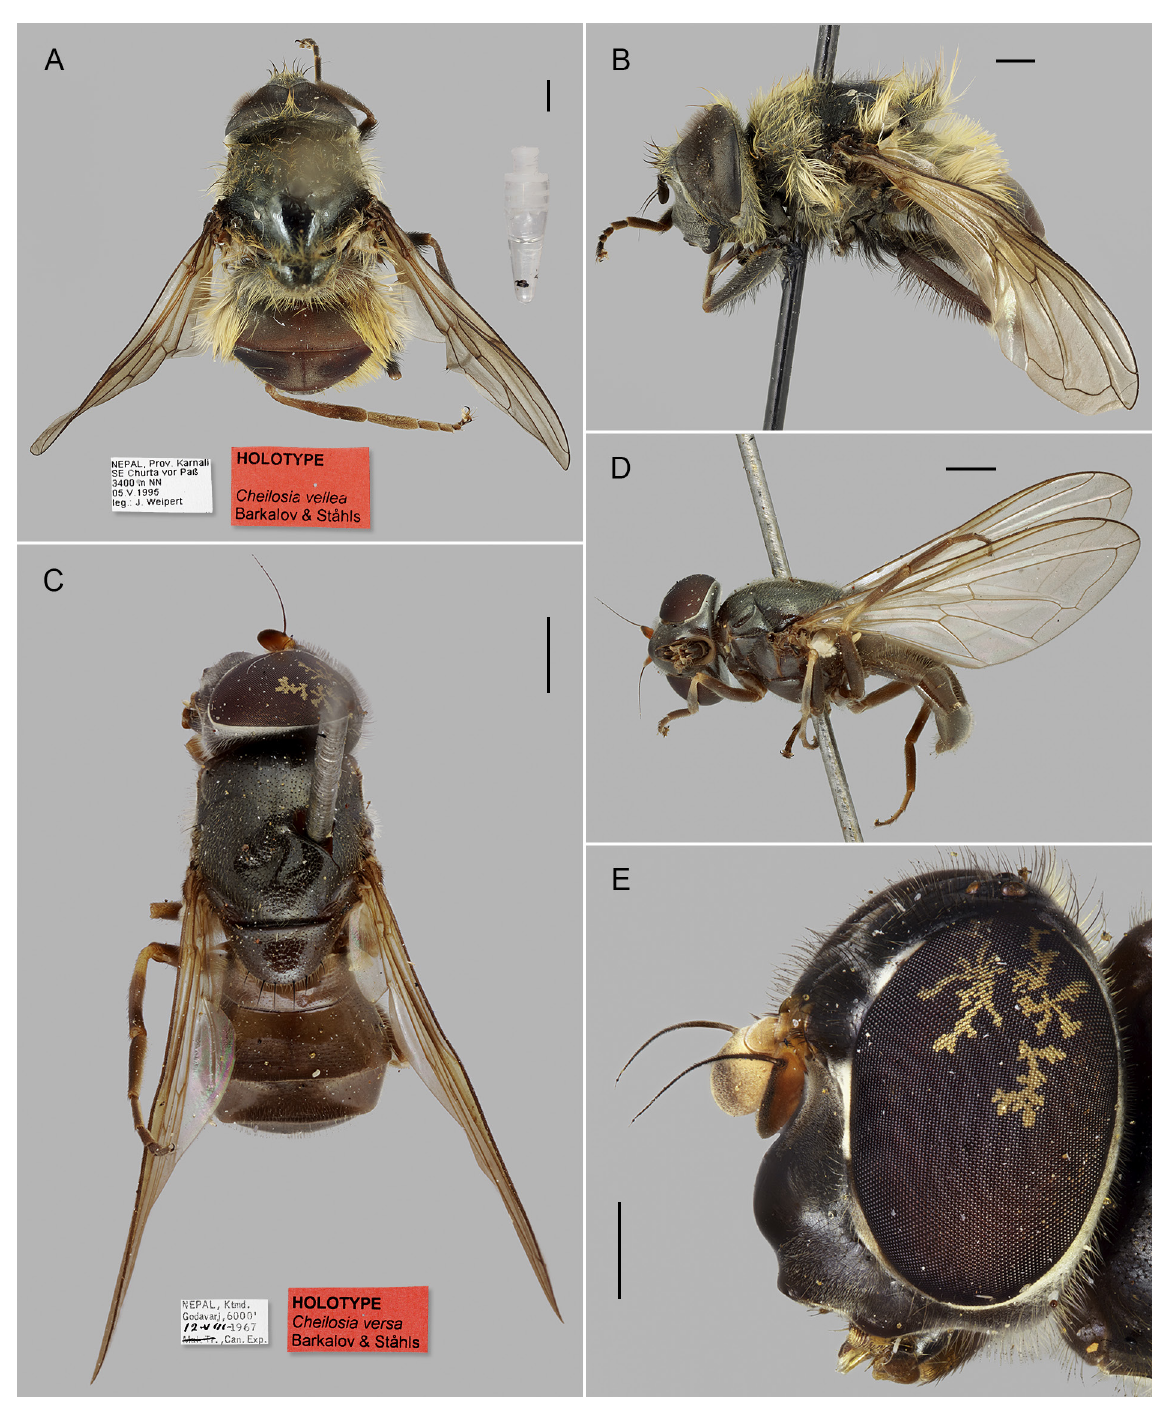
Fig. 64. A–B . Cheilosia ( Floccocheila ) vellea sp. nov., holotype ♂ (BSJW/NME); dorsal and lateral view. – C–E . Cheilosia versa sp. nov., holotype, ♀ (CNC); dorsal and lateral views. Scale bars: A–D = 1 mm; E = 0.5